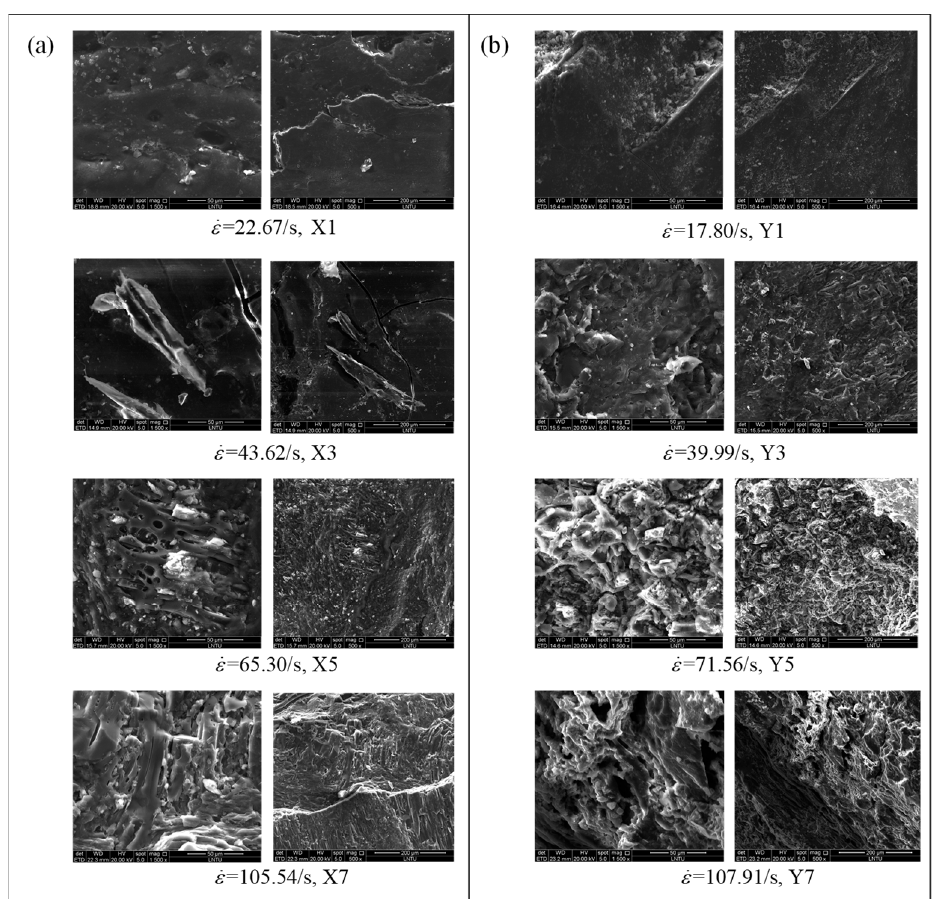
Figure 8. Scanning electron microscope (SEM) images of coal specimens failed at different strain rates: ( a ) Xinzhouyao coal (resistant), and ( b ) Xintian coal (prone).